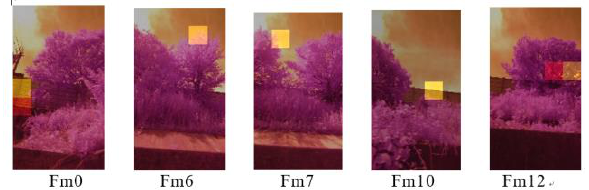
Figure 23. Extracted degrading blocked